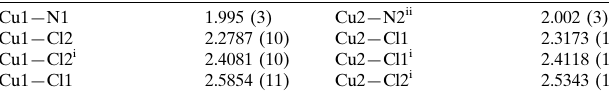
Selected bond lengths (A˚ ).